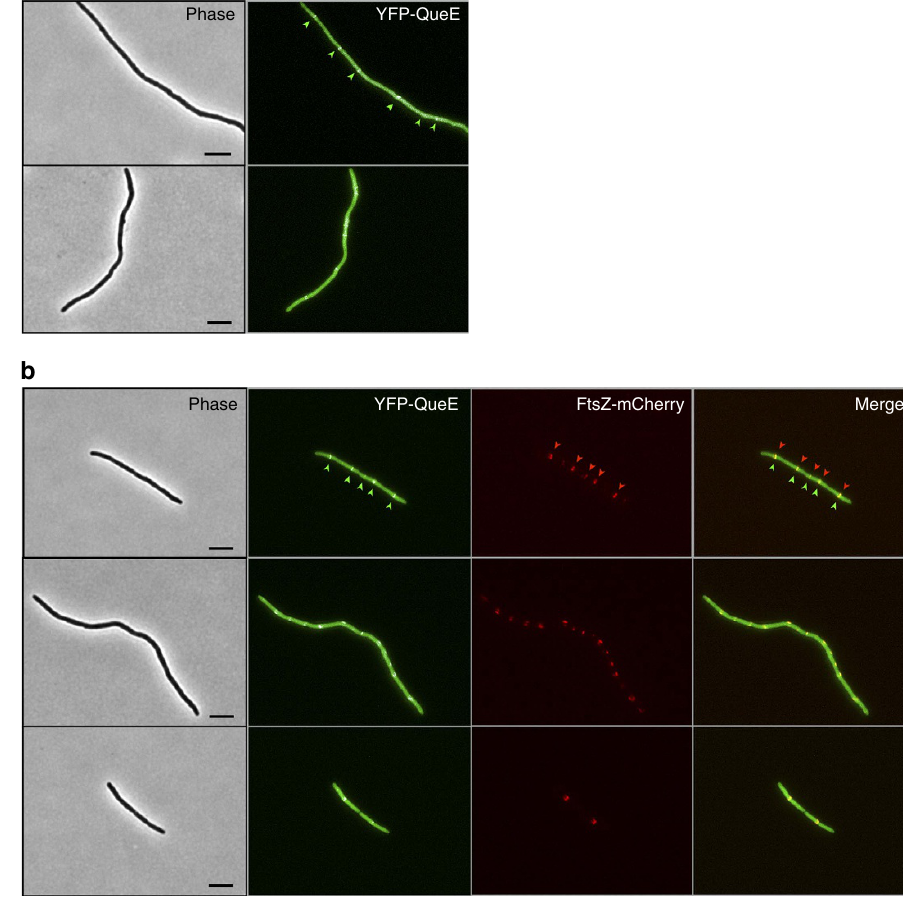
Figure 5 | QueE localizes at the Z-ring in E. coli filaments. ( a ) Two representative phase contrast and fluorescence micrographs showing cellular localization of YFP-QueE expressed from a plasmid in D queE cells (SAM144/pSY76). Cultures were grown in minimal medium containing 1mM Mg 2 þ and ampicillin (50 m gml (cid:2) 1 ) to an OD 600 ¼ 0.2–0.3 and observed by microscopy (see Methods for details). Arrows in one of the micrographs point to spots of increased YFP fluorescence. ( b ) Three representative phase contrast and fluorescence micrographs showing co-localization of FtsZ-mCherry and YFP-QueE expressed from plasmids pEG4 and pSY76, respectively, in D queE cells (SAM144). The arrows in one set of images point to the spots of increased YFP and mCherry fluorescence. Cultures were grown in minimal medium with 1mM Mg 2 þ , ampicillin (50 m gml (cid:2) 1 ) and chloramphenicol (25 m gml (cid:2) 1 ) to an OD 600 ¼ 0.2–0.3 and observed by microscopy. Scale bar, 5 m